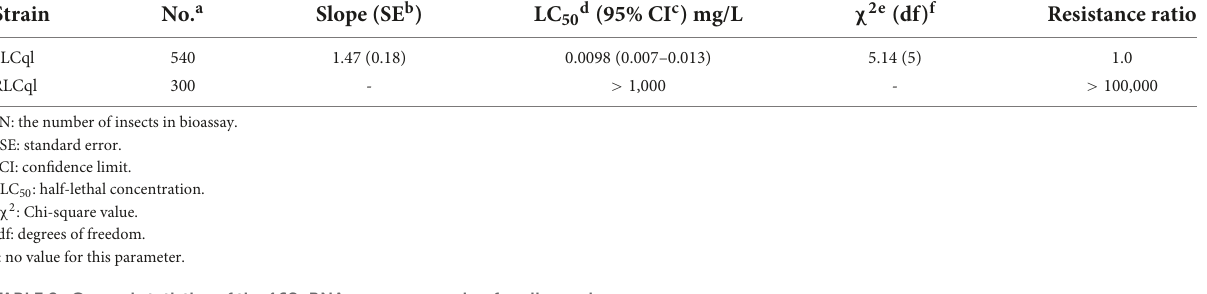
TABLE 2 General statistics of the 16S rRNA gene sequencing for all samples.